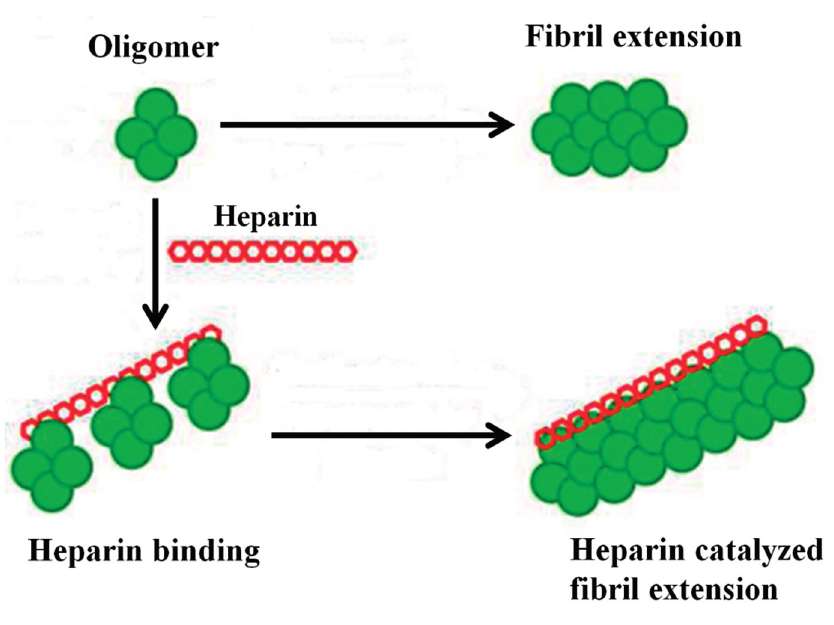
Figure 3. Alignment of oligomers on heparin molecules accelerates the process of fibril formation. Adapted from Solomon et al.